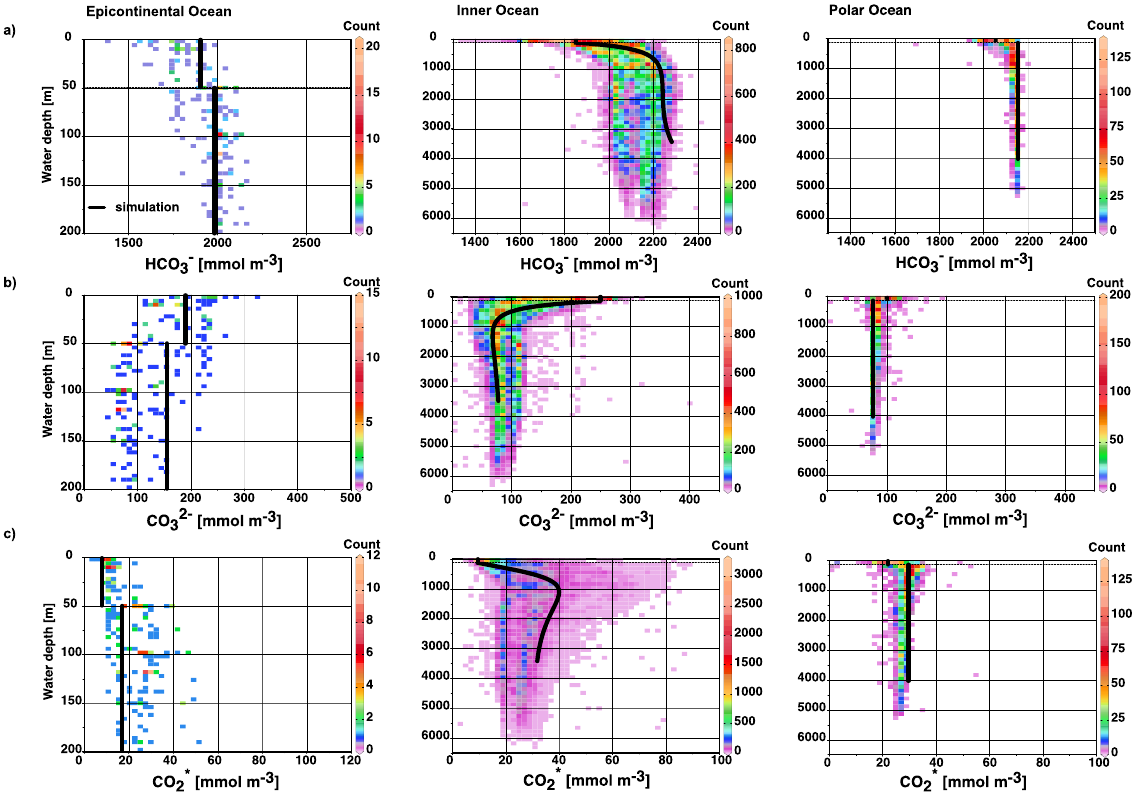
Fig. 8. Simulated steady state depth-profiles of carbonate species in the epicontinental, inner and polar ocean (black line). Simulation results are compared to derived from the WOCE Hydrographic Program (*hy1.csv files from WHPO web-site as of 27 May 2002) observations using the in-situ temperature, pressure, T C and T A (Fig. 7) The colour code indicates the number of times a concentration is reported for a given water depth.